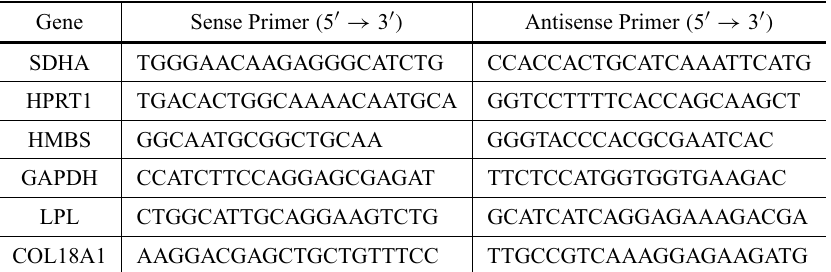
Sequence of the primers used in the Quantitative Real-Time PCR experiment. Gene Sense Primer ( 5 (cid:3) → 3 (cid:3) ) Antisense Primer ( 5 (cid:3) → 3 (cid:3)